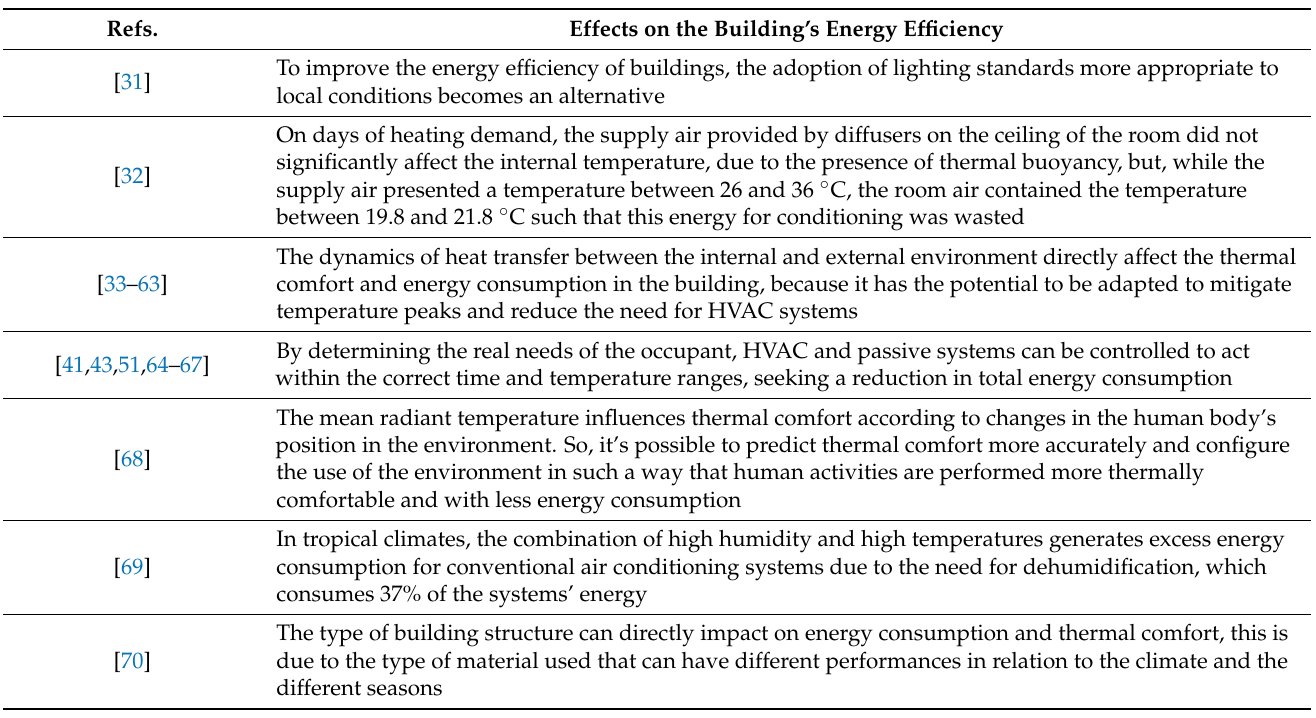
Figure 6. Aspects of the thermal state. Table 1. Main effects on energy